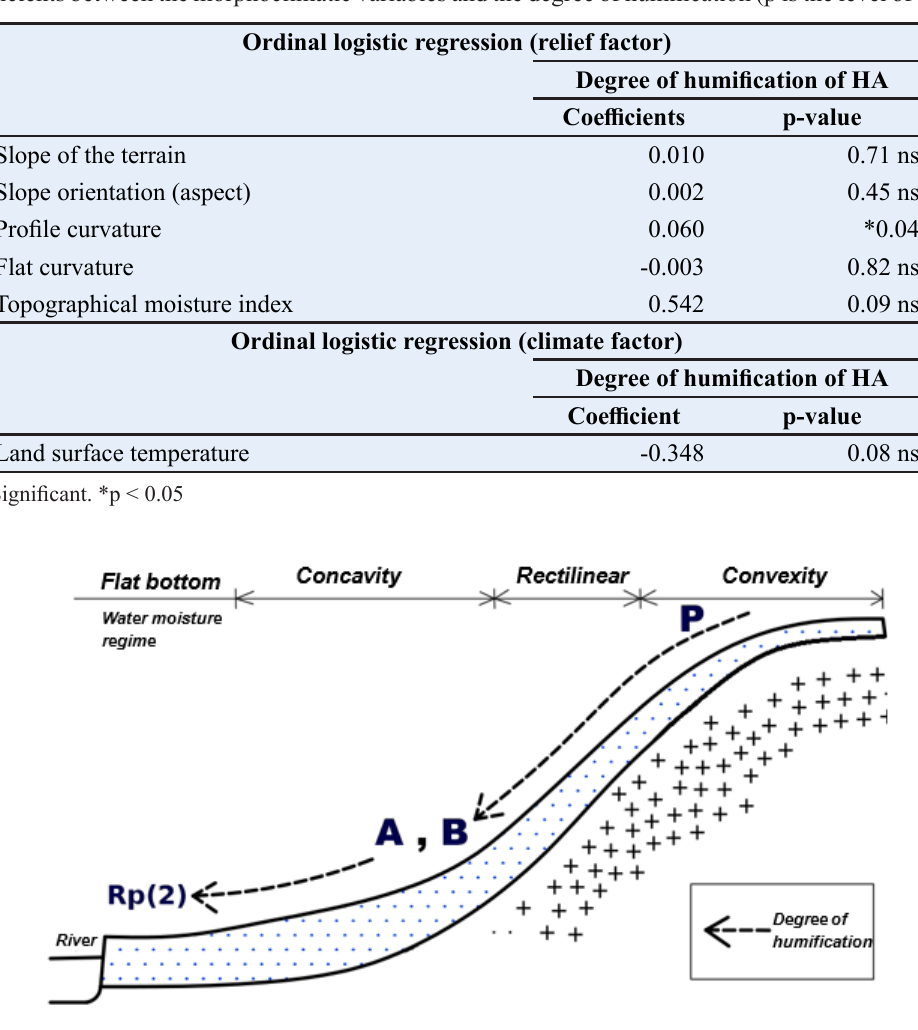
Figure 4 : Degree of humification in the profile curvature of the slope